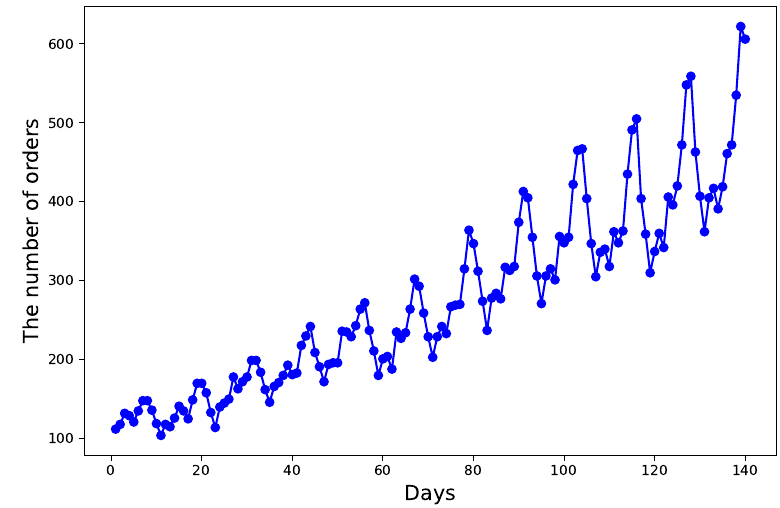
Figure 9. Historical demand with a rising trend.